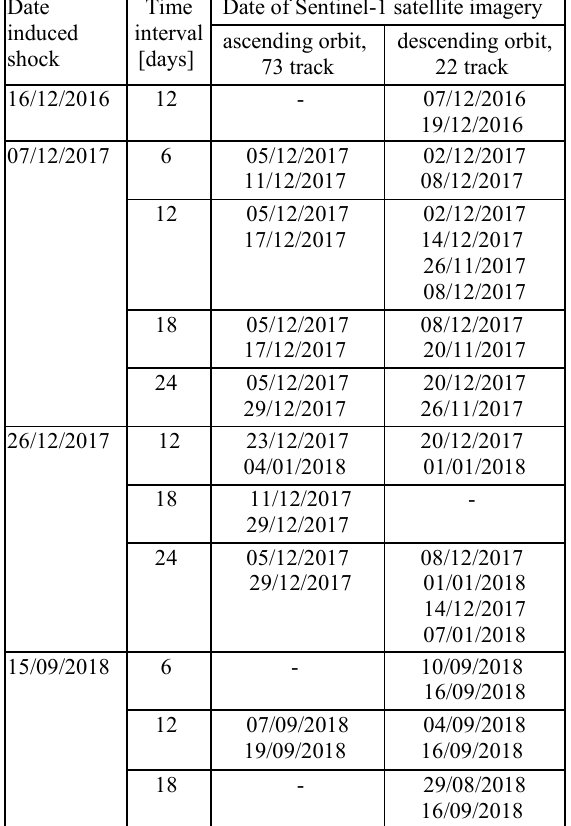
Table 1. List of the Sentinel-1 data processed for the four analysed seismic events.